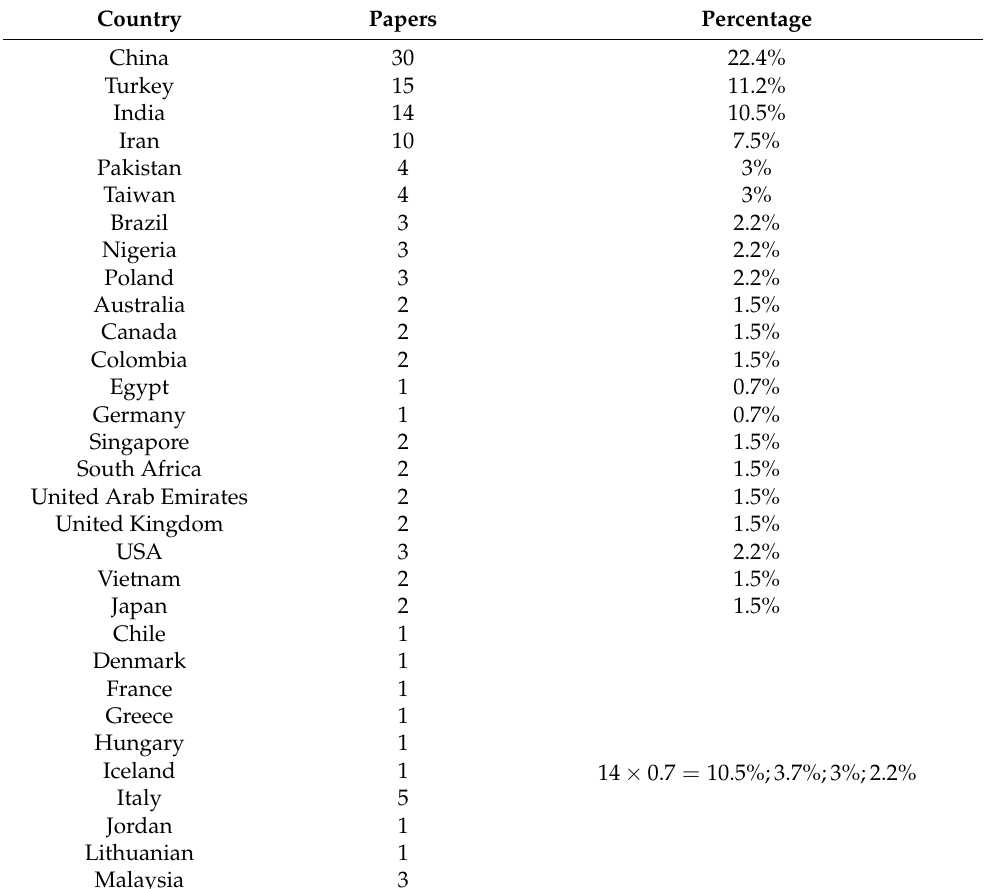
Table 4. Country-wise distribution articles pertaining to CES